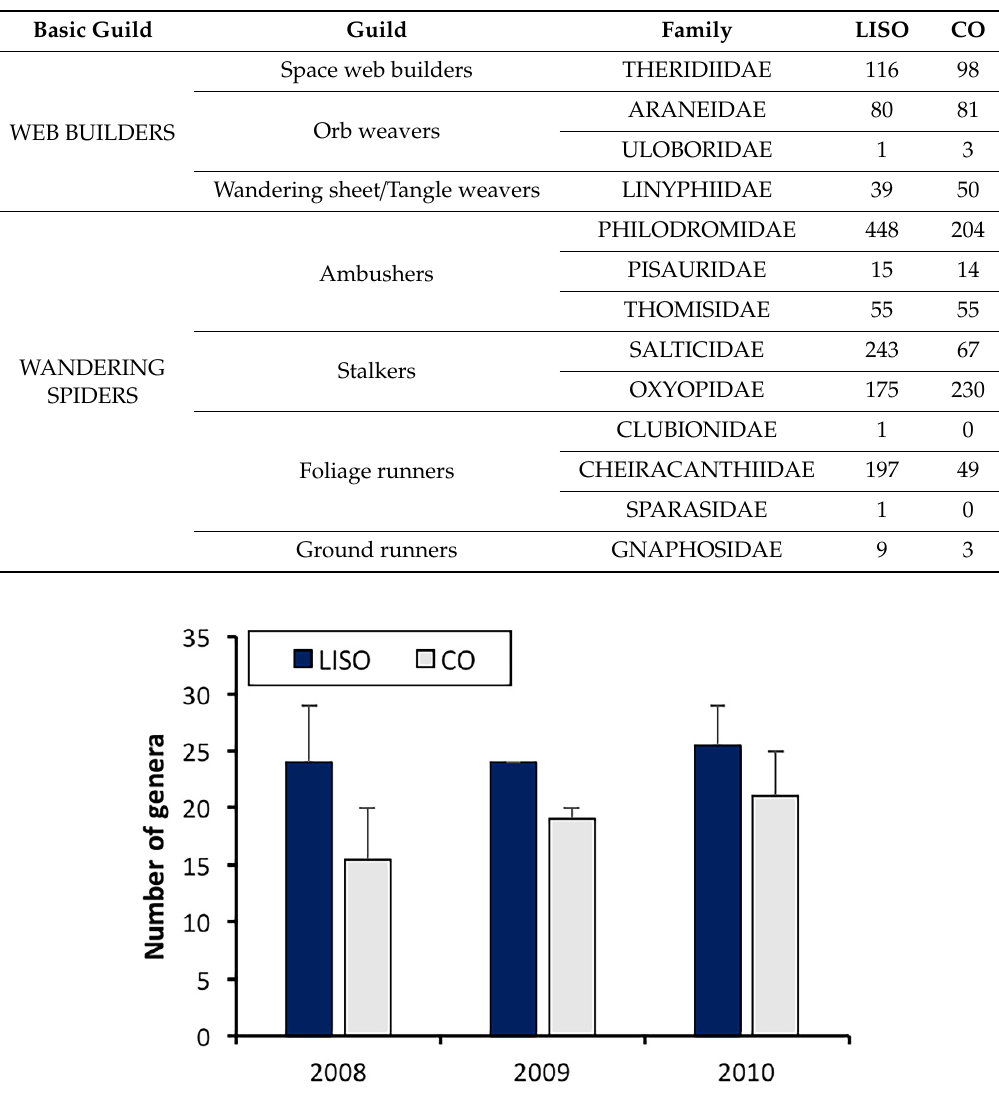
Table 1. Number of individuals collected in di ff erent families of spiders grouped in guilds, both basic and according to the criteria of Uetz et al. [44], in low-intensity spraying (LISO) and conventional (CO) pear orchards.